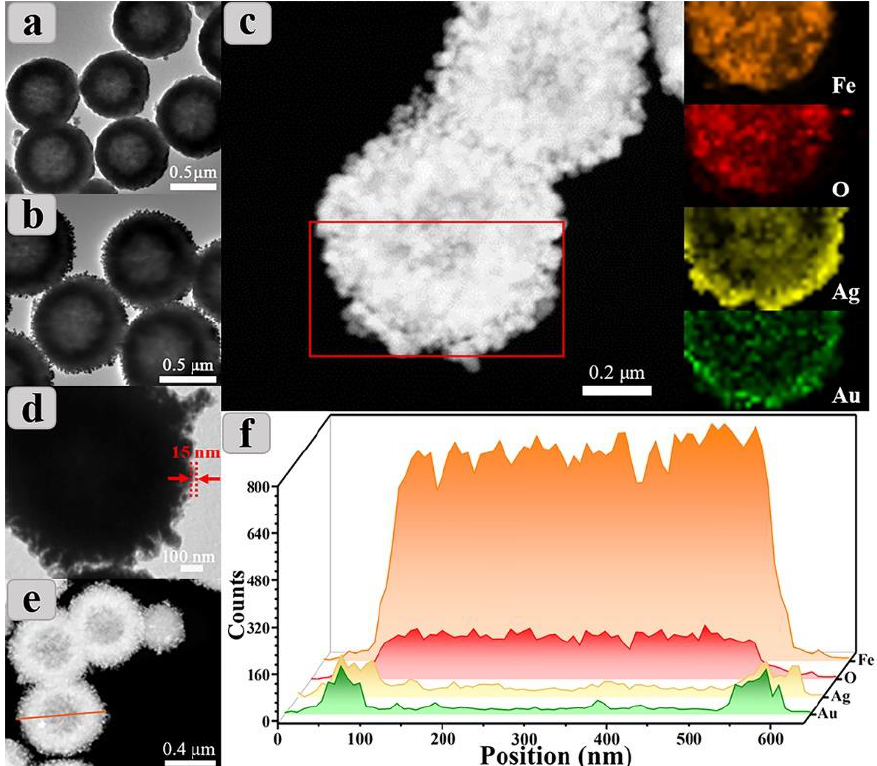
Figure 2. TEM images of Fe 3 O 4 hollow spheres ( a ) and FA NCs ( b ). Dark-field TEM images and EDS elemental mapping results (O, Fe, Au and Ag) of FA@Ag NCs ( c ). TEM image of FA@Ag@PEI-DTC NCs ( d ). Dark-field TEM images ( e ) and EDS line scanning spectra of CSSN NCs ( f ). The valence of elements in CSSN NCs was determined by XPS technology. Full XPS spectra of Fe 3 O 4 hollow spheres, FA, FA@Ag, and CSSN NCs are exhibited in Figure S3. Within detection limit of XPS, Fe 2p, O1s, Au 4f, Ag 3d, and C 1s were observed and no impurity was found. High-resolution XPS results of Ag 3d and Au 4f are reflected in Figure 3. Ag 3d spectra in Figure 3a display peaks at 368.2 and 374.2 eV with a spin-orbit splitting of 6 eV for CSSN NCs, which are attributable to characteristics of Ag 3d 3/2 and Ag 3d 5/2 of Ag 0 [53]. As represented in Figure 3b, peaks of CSSN NCs at 84.1 and 87.8 eV with an energy difference of 3.7 eV are attributable to Au 4f 7/2 and Au 4f 5/2 of Au 0 [54,55]. An interesting phenomenon is that the binding energy of Ag 3d as well as Au 4f changes slightly with the incremental introduction of noble metals. The positions of Ag 3d peaks of CSSN NCs are blue-shifted compared with FA@Ag NCs, and the positions of Au 4f peaks are red-shifted compared with FA@Ag and FA NCs. This shift in binding energy may be ascribed to the charge transfer from metallic Au to Ag